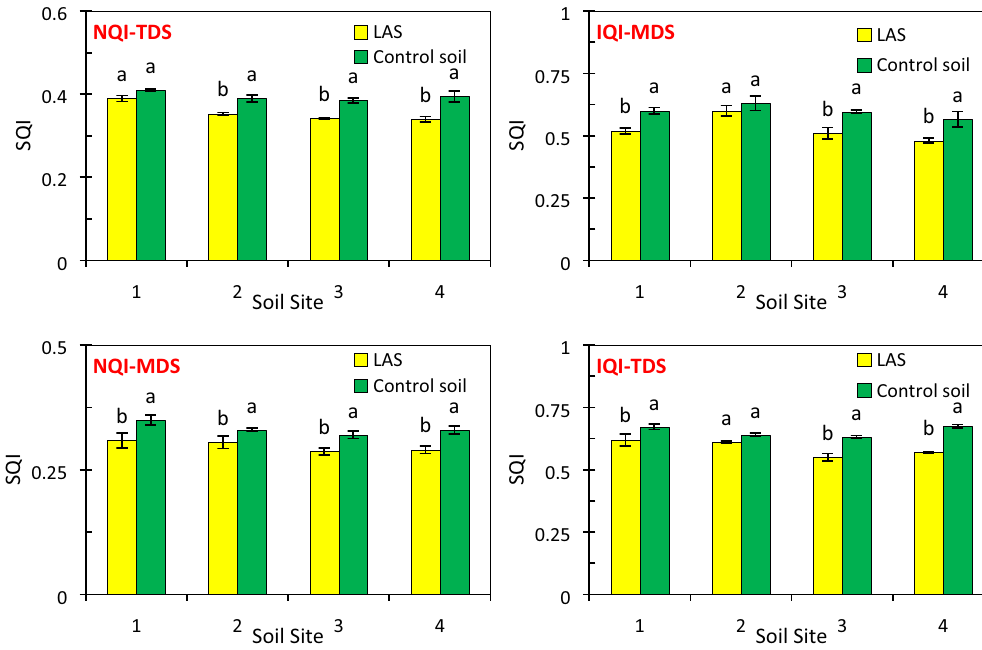
Figure 2. The comparison of the mean values of different soil quality index (SQI) scenarios between the leachate-affected soil (LAS) and the control